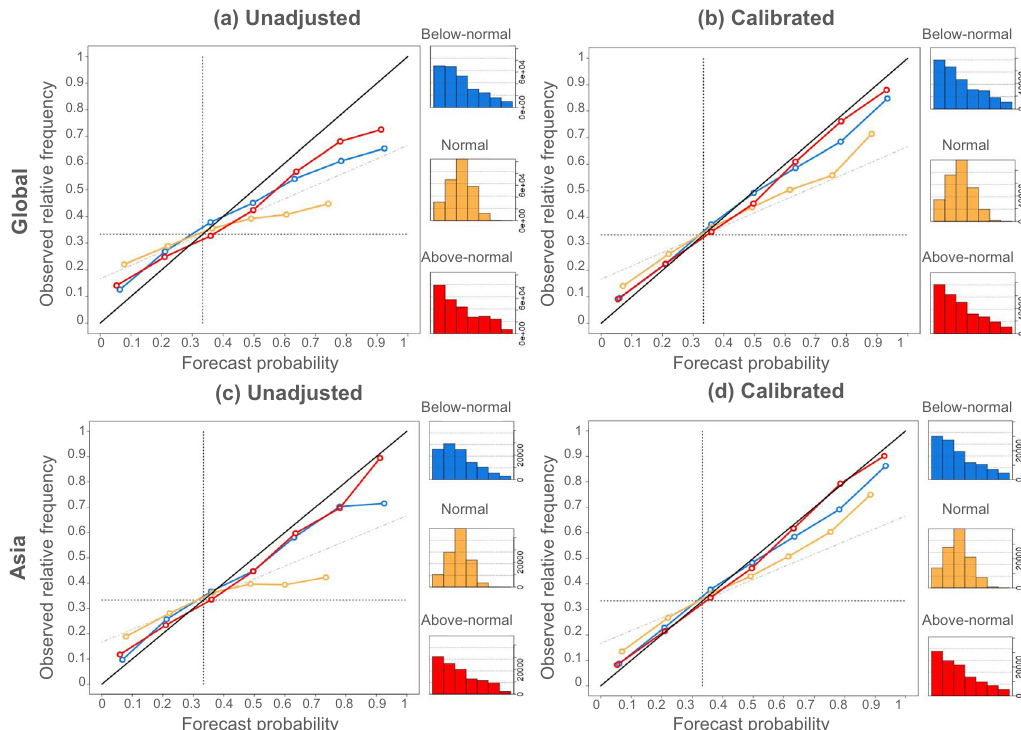
Fig. 4 Reliability of the heat stress index. Same as Fig. 2 but for the Heat Magnitude Day Index index (Fig. 6e, f), Ravenna (Supplementary Fig. 17a, b) and Foggia (Supplementary Fig. 17c, d). The three locations are selected by choosing the grid point in which each of the region falls. These areas were identi fi ed by the stakeholders in the EU H2020-MED- GOLD project to be among the leading regions used for the production of durum wheat in Italy and have also become, along with rest of the Mediterranean regions, prone to increasing temperatures and more frequent and intense extreme events such as droughts and heatwaves 3 . Figures 6a – d presents the predicted likelihood map (in %) of the most likely tercile (labeled as below- normal, normal and above-normal) of observed drought and heatwave occurrences using the indices corresponding to the wheat harvesting season (Supplementary Fig. 1) and for the regions where calibrated forecasts return positive FRPSS. Darker shades of brown (blue), yellow and green (red) correspond to a higher probability of occurrence of the event falling into the lower, middle, and upper tercile category of SPEI6 (HMDI3), respectively. The decadal predictions for both indices show an